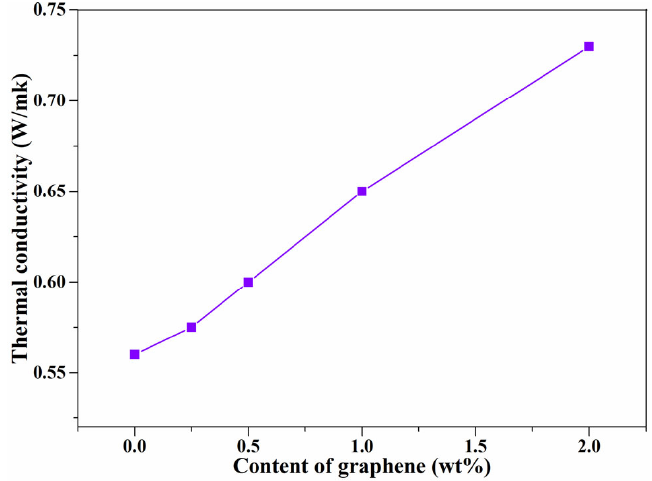
Figure 5. Thermal conductivity of PE and graphene/PE composites.